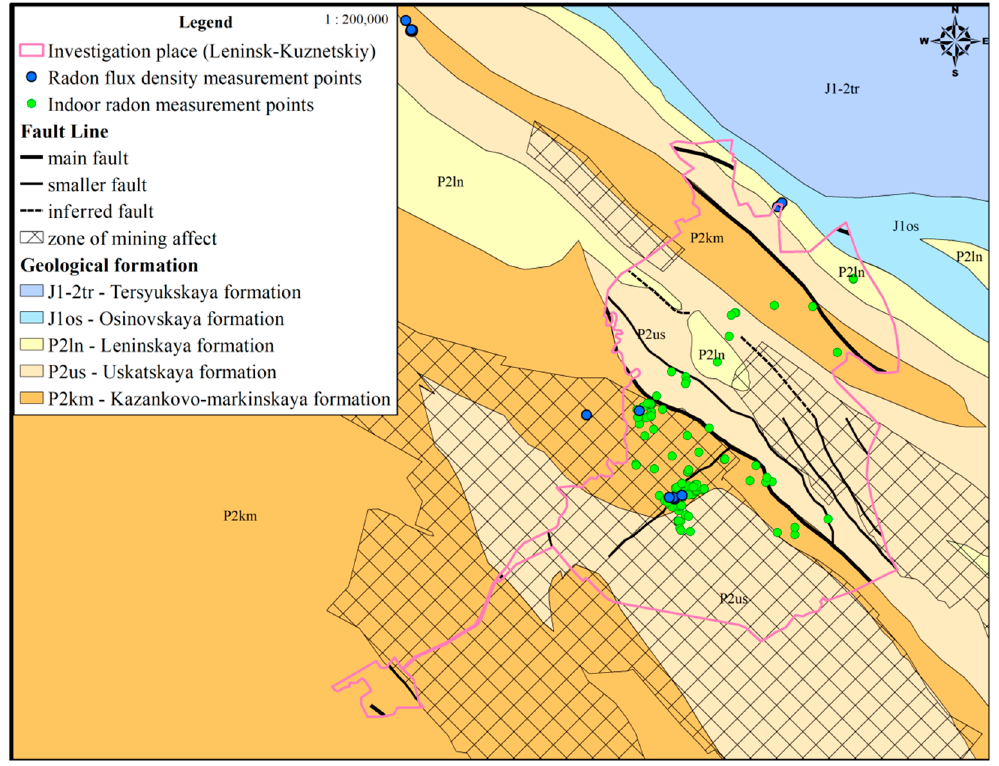
Figure 1. Geological map of the Leninsk-Kuznecky district with zone of mining affect.